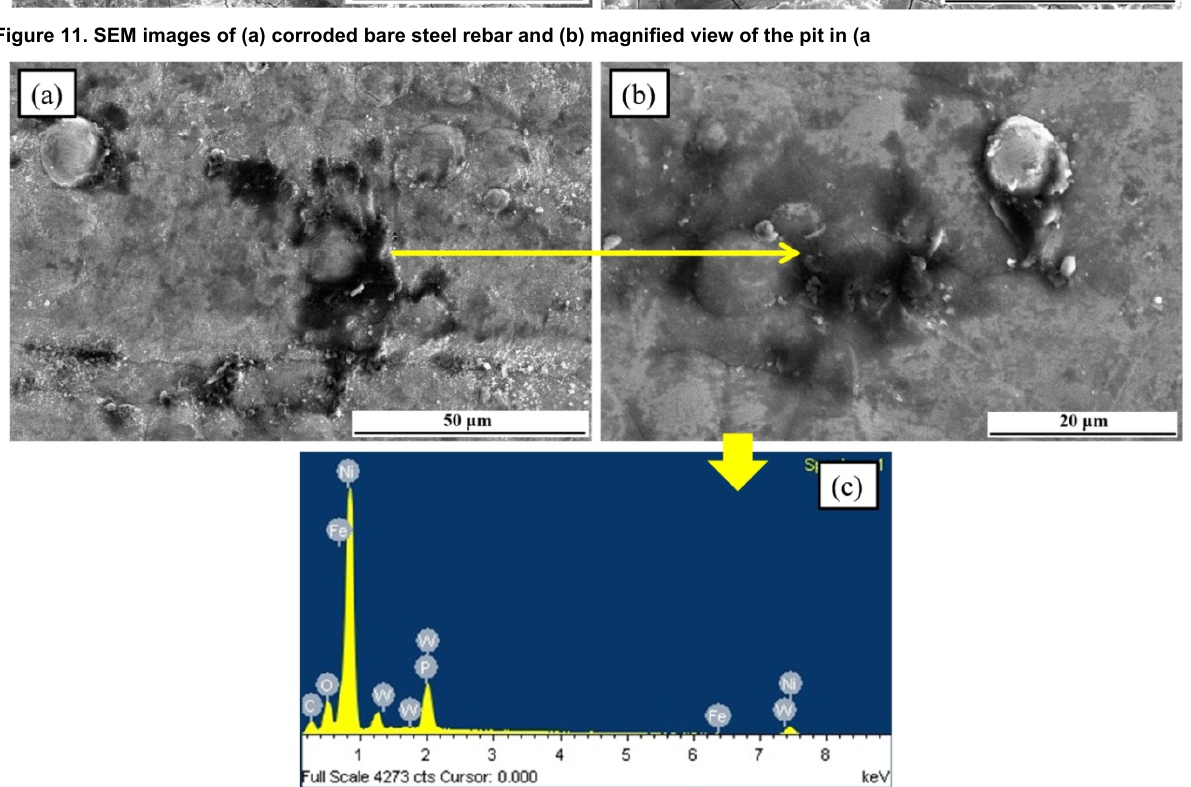
Figure 12. SEM image of (a) corroded Ni-P-W coated rebar for the combination of bath parameters at mid-level and (b) magnified view of the blackish patches in (a). The EDS analysis of blackish patches in (b) is shown in